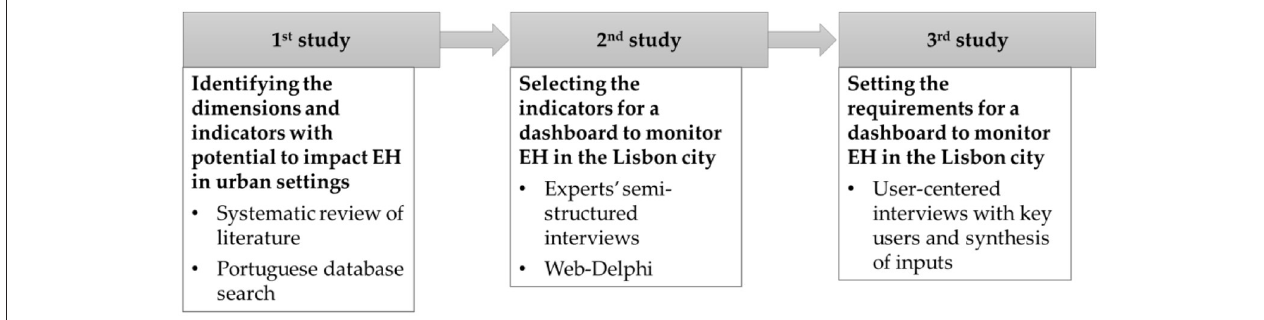
FIGURE 1 | Overview of the research process adopted to move toward the design and construction of an evidence-based dashboard to monitor EH in the Lisbon